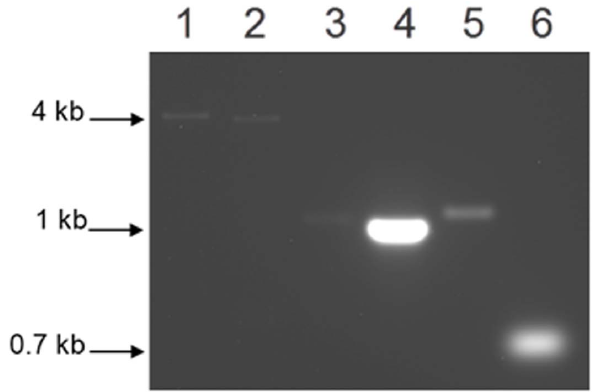
Figure 1. RT-PCR analysis of P.gingivalis W83. DNase treated total RNA extracted from P. gingivalis W83 and subjected to RT-PCR. Lane 1, amplification of 4.3 kb uvrA-PG1037 fragment; Lane 2, amplification of 3.7 kb PG1037-pcrA fragment; Lanes 3, 4 and 5, intragenic specific primers for uvrA , PG1037 and pcrA genes amplified a 1.2 kb, 1.0 kb and 1.3 kb fragments respectively; Lane 6, amplification of 0.7 kb 16S fragment.